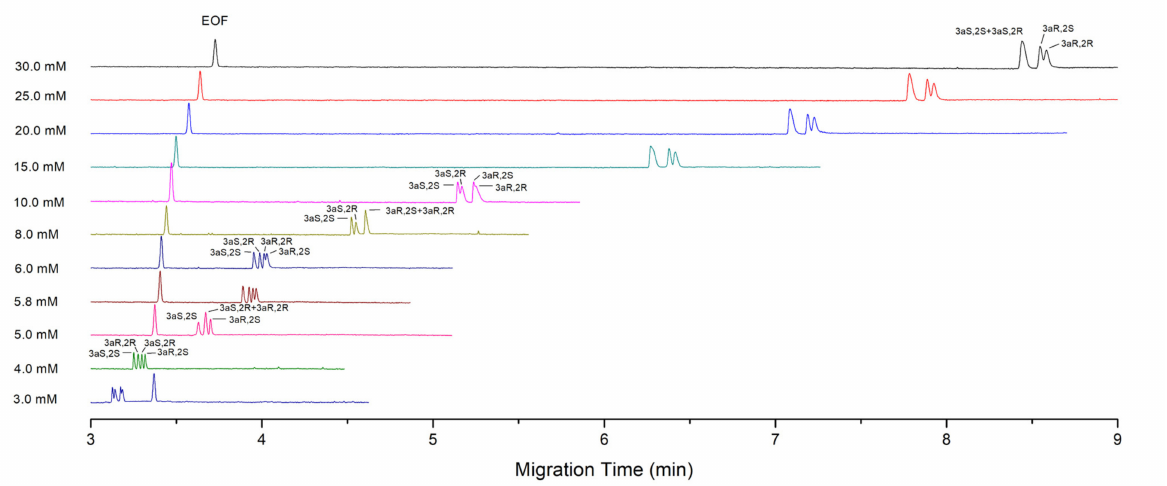
Figure 2. Electropherograms of PALO stereoisomers obtained with different concentrations of SDC. Component of micellar solution is SDC of annotated concentrations in 30 mM sodium tetraborate buffer of pH 9.2. Sample concentration: 0.1 mg · mL − 1 for each stereoisomer. Hydrodynamic injection at 5 kPa, 2 s and 1 s for the SDC concentration of 30.0–10.0 mM and 8.0–3.0 mM, respectively. Detection wavelength: 214 nm. Other CE conditions are the same as in Figure